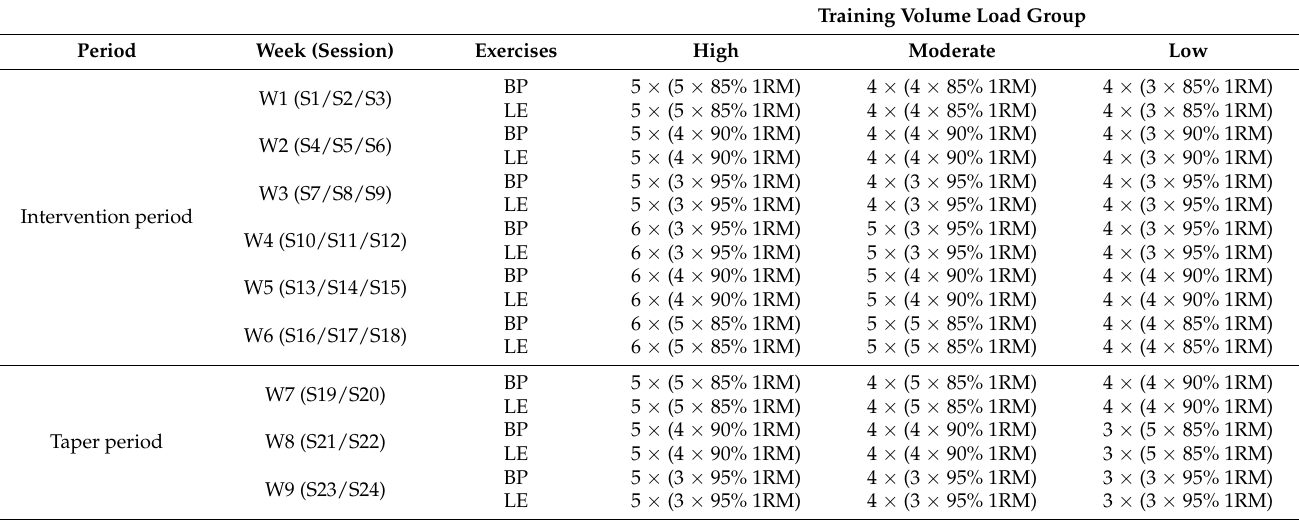
Table 2. Detailed description of the 9-week MST in the three groups.